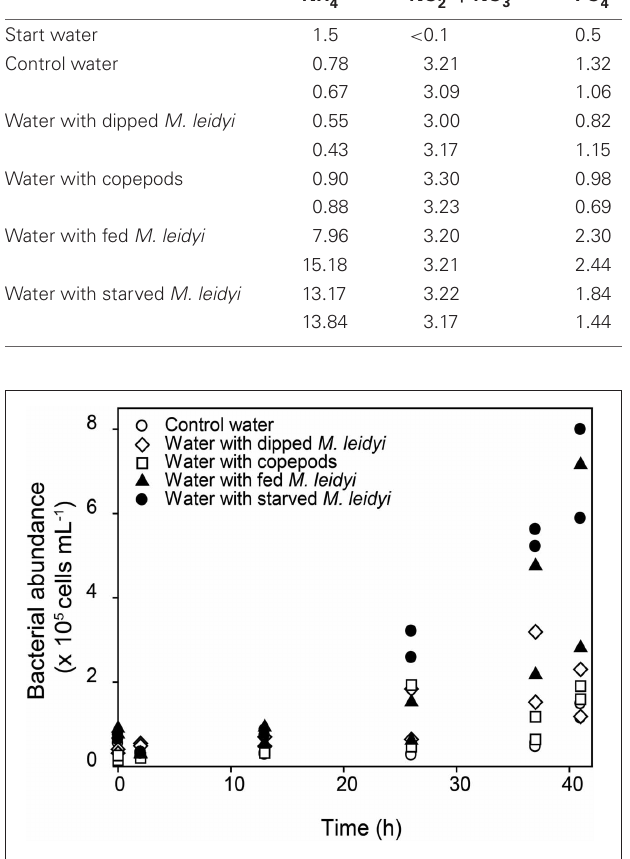
FIGURE 1 | Changes in bacterial abundance over time. White symbols represent control treatments and black symbols represent treatments with M. leidyi . Data from both replicates are shown for all